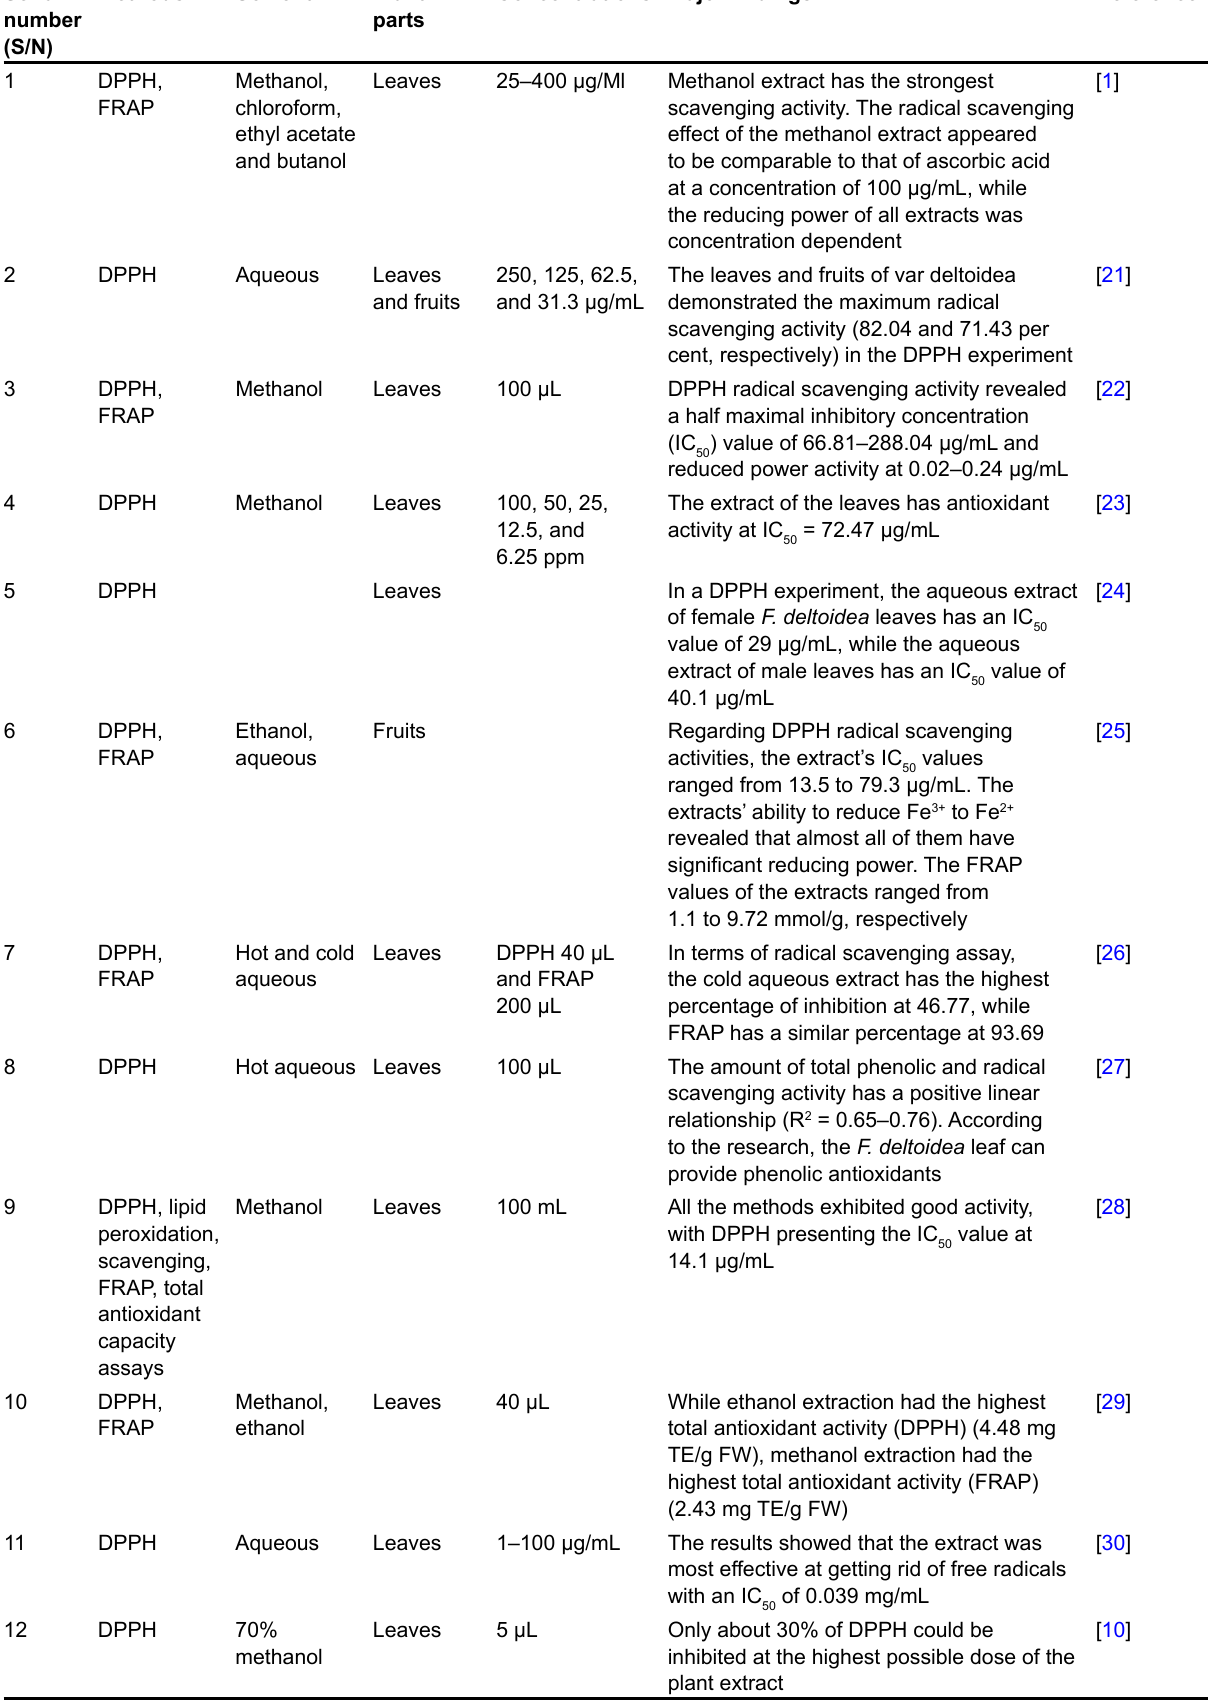
Table 1. Antioxidant activities of